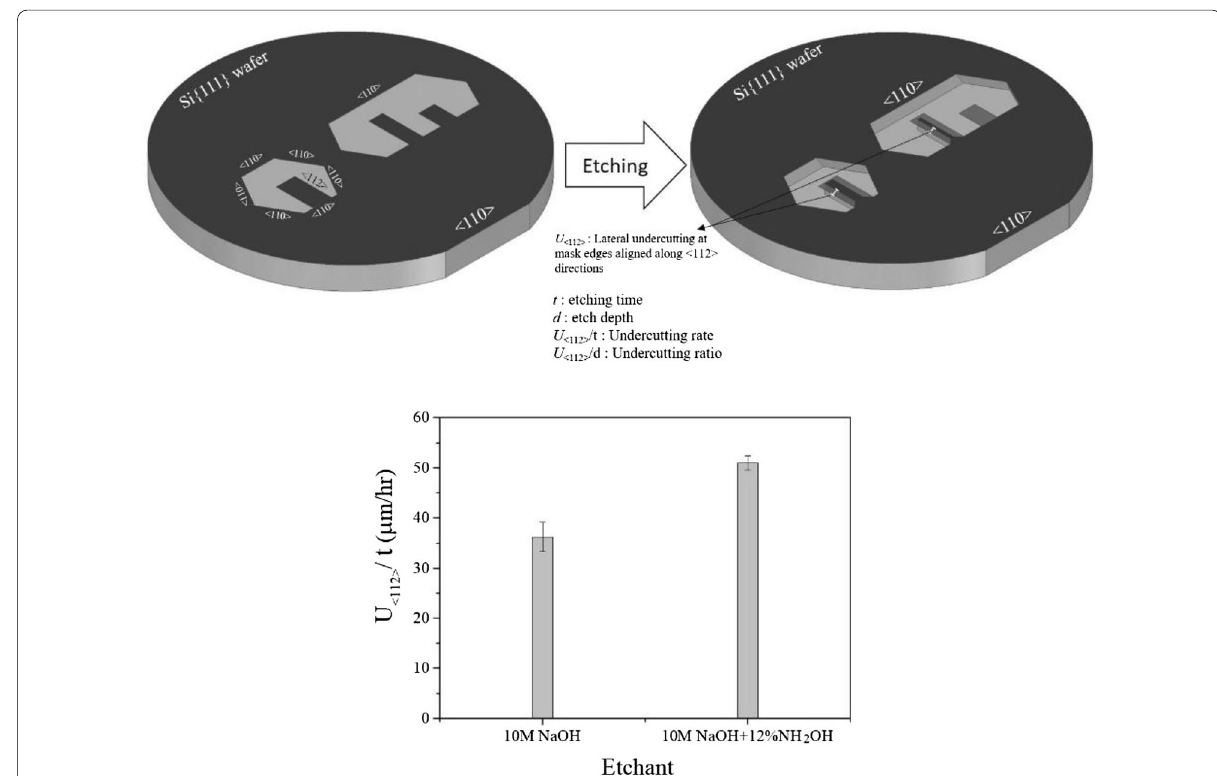
Fig. 8 Lateral undercutting rate at the mask edges aligned along < 112 > direction on Si{111} in pure and NH 2 OH-added NaOH at 70 °C